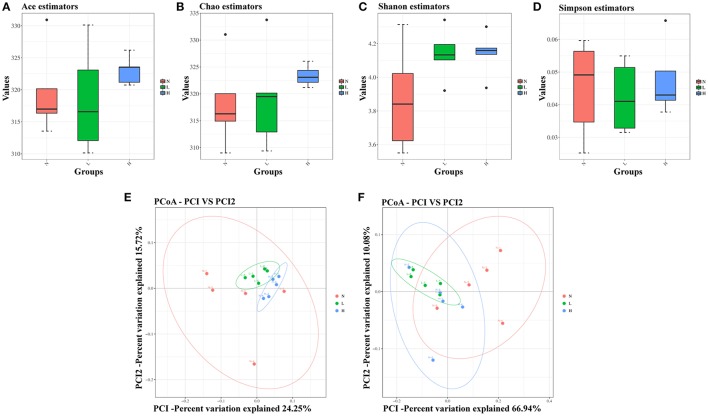
Effect of dietary capsaicin on the gut microbiota structure. (A) Ace estimator, (B) Chao estimator, (C) Shannon index, (D) Simpson index, (E) unweighted UniFrac distance-based principal coordinate analysis (PCoA), (F) weighted PCoA. N, normal diet group (n = 5); L, low-capsaicin diet group (n = 5); H, high-capsaicin diet group (n = 5). Data are shown as box and whisker plots. The box indicates the interquartile range (IQR, 75th to 25th percentiles of the data), and the mean value is shown as a line within the box; whiskers extend to the most extreme value within 1.5 × IQR, and outliers are shown as black dots. The results were analyzed by one-way ANOVA with Tukey's post hoc test or the Kruskal–Wallis test.